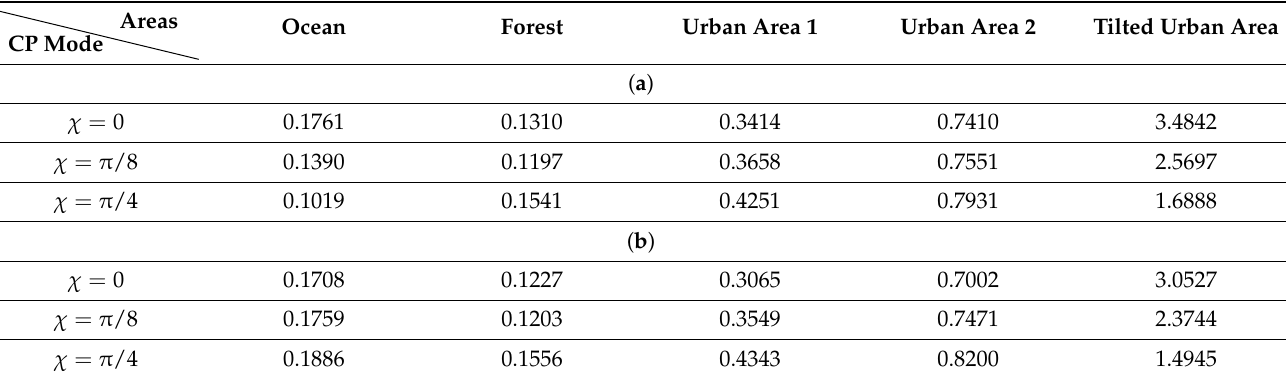
Table 4. Relative errors of the reconstructed log (cid:104)| S HV | 2 (cid:105) for the outlined areas in Figure 2c by using ( a ) the IterNCD method, and ( b ) the IterNVD method. The CP modes are with θ = π